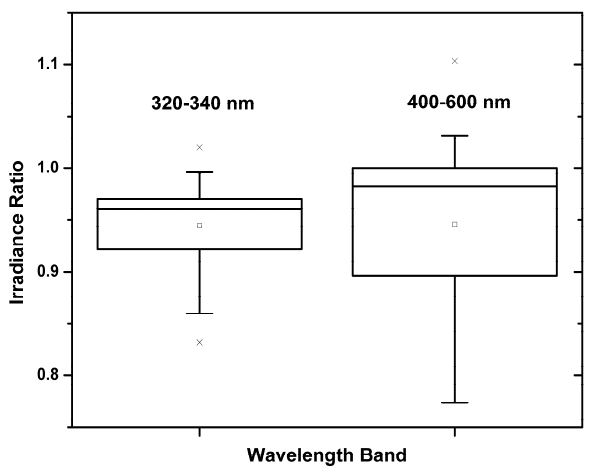
Fig. 5. Box plots of all irradiance ratios for the 320–340nm and 400–600nm wavelength bands. The upper and lower boxes, respec- tively, for each wavelength define the second and third quartiles of the measurements. The upper and lower vertical lines, respectively, define the first and fourth quartiles. Small squares in the third quar- tile for each wavelength represent means, and the x-symbols are outliers.